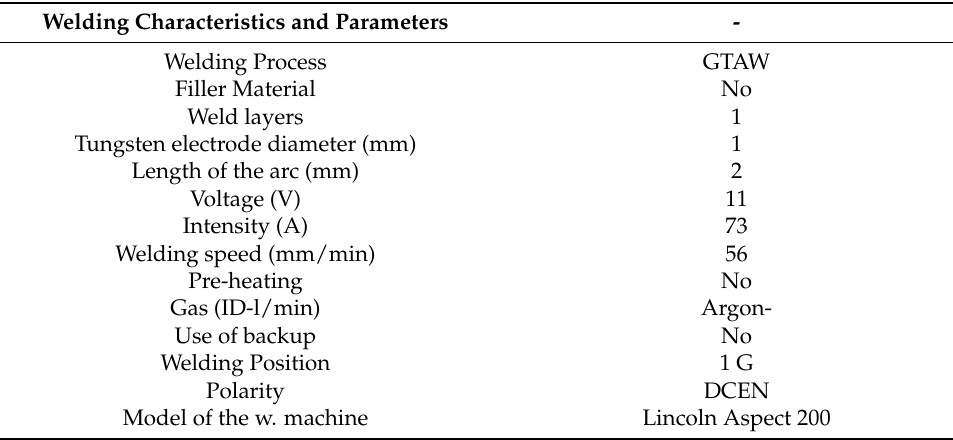
Figure 1. Schematic picture of the welding test samples. Table 3. Welding characteristics and